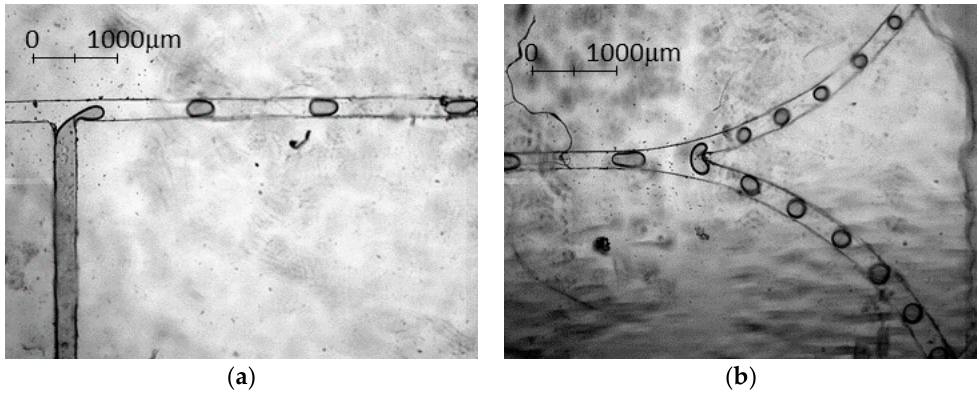
Figure 11. Droplet fission from the high speed camera of 1:1 curvature ratio at dispersed flowrate of 2 μ L/min and continuous flowrate of 6 μ L/min: ( a ) water droplet breakup at the T-junction; and ( b ) the droplet fission where a mother droplet breaks up into two daughter droplets. The blurriness of the images was caused by the cooking oil stain, which adhered to the top of the device surface during the experiment.